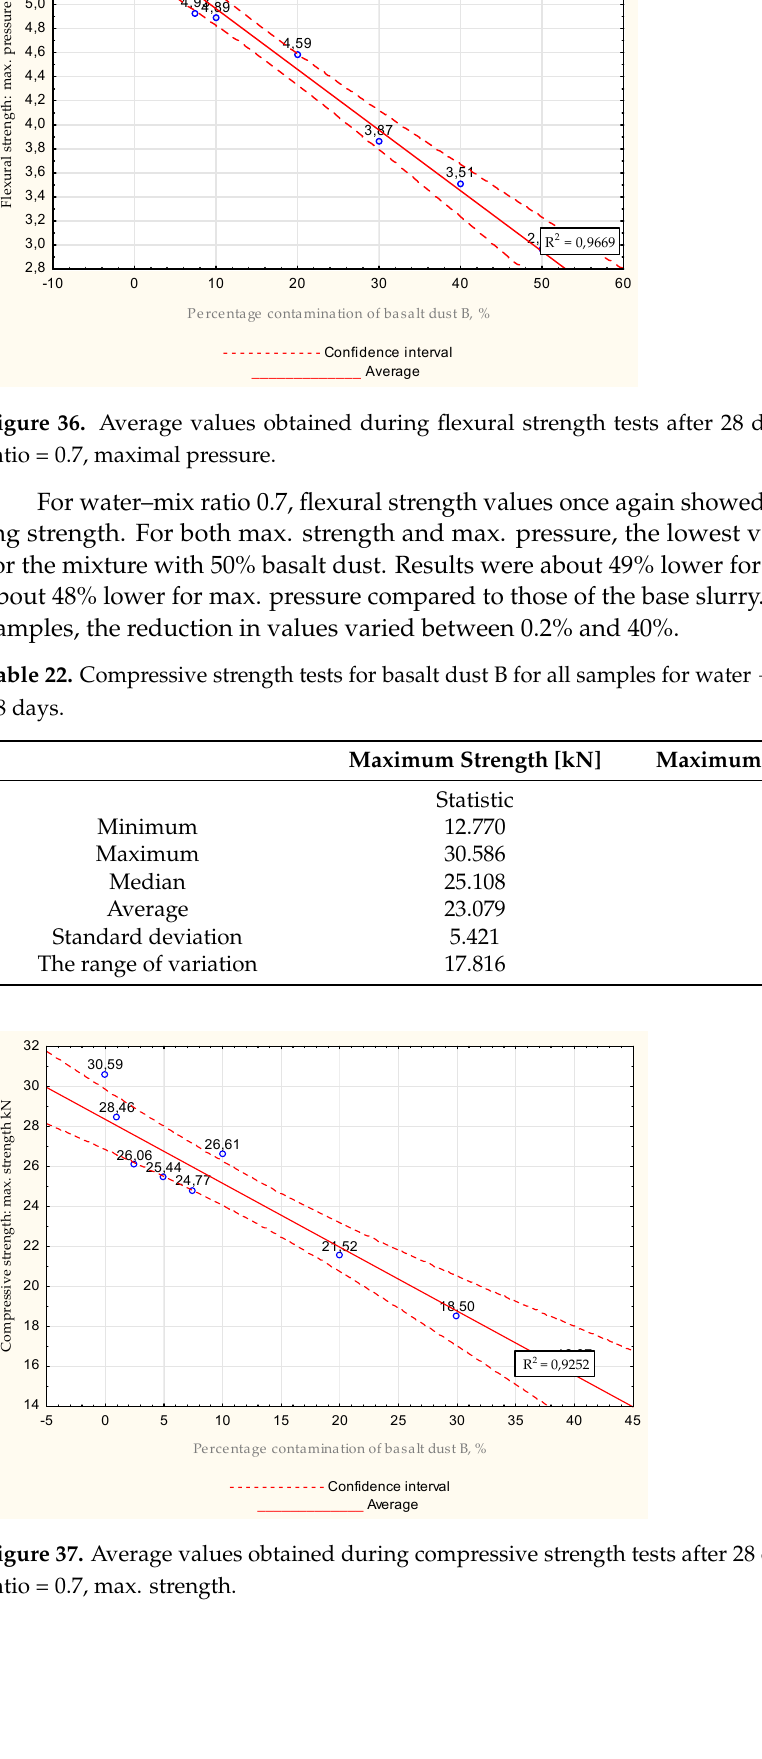
R 2 = 0,9144 Figure 38. Average values obtained during compressive strength tests after 28 days for water − mix ratio = 0.7, max. pressure.